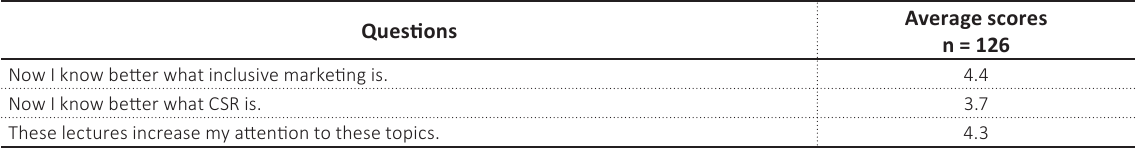
Table 5. Mentimeter trial: Results about training effectiveness